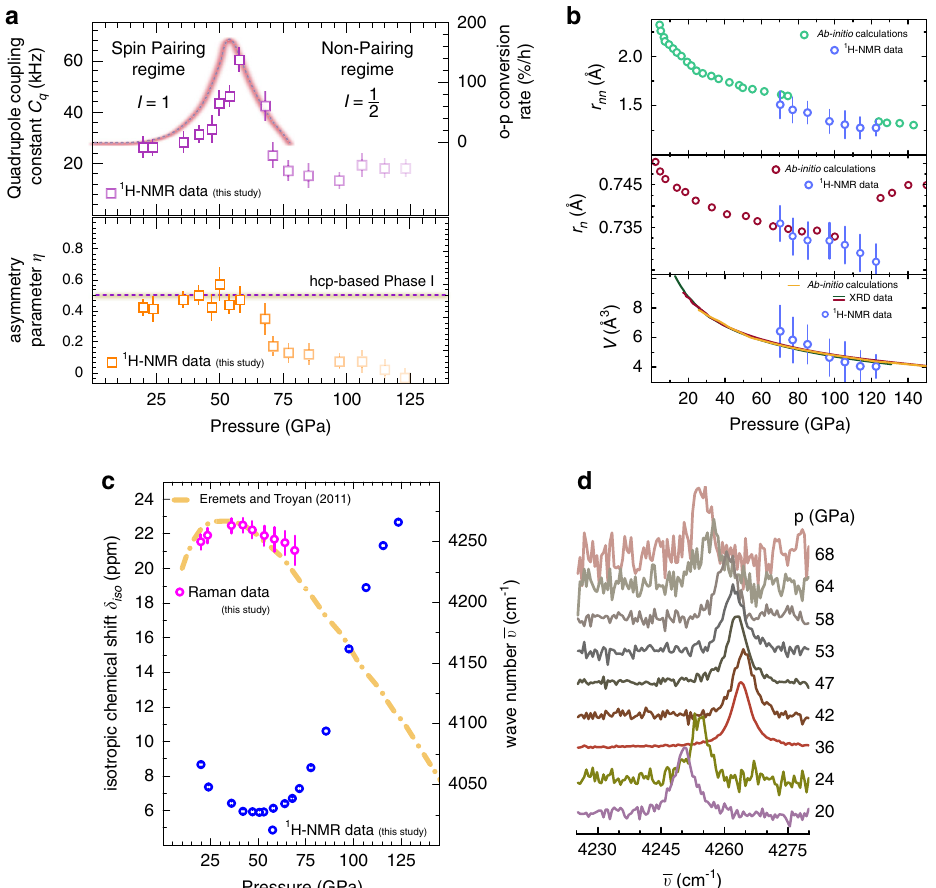
Fig. 3 Extracted 1 H-NMR data of molecular H 2 at pressures up to 123 GPa at room temperature. a Top panel: quadrupole coupling constant C q determined from NMR data (squares). The rose line denotes theoretical ortho – para conversion rates from electric quadrupole interaction 27 . Bottom panel: asymmetry parameter η in the spin-pairing regime ( P < 60 GPa). The dashed line represents the inferred η based on the hcp structure of Phase I from diffraction experiments. The shading of the squares at P > 60 GPa highlights the crossover to the non-pairing I = 1/2 regime. b Top panel: next-nearest neighbour distances r nn . Green circles are based on DFT computations 15 . Blue circles are extracted values of r n and r nn from the NMR spectra in the non- pairing I = 1/2 regime. Middle panel: nearest neighbour distances r n (blue circles) and DFT calculations 15 (red circles). The discontinuity at P > 125 GPa in the DFT calculations indicates a transition from the hcp based to a monoclinic structure. Bottom panel: comparison between the equations of state derived from ab initio computations 23 (yellow line) and diffraction data 14,21 along with the unit cell volumes (blue dots) derived from r nn and r n extracted from the NMR experiments. c Extracted isotropic chemical shift values δ iso after homonuclear Lee – Goldberg decoupling. Error bars are within the symbol size. The orange dotted line shows the room temperature Raman shift of the H 2 vibron 25 . d Selected Raman spectra of the H 2 vibron at increasing pressure. Spectra up to 64 GPa are taken from ref. 25 . Error bars in a and b were taken from spectral simulation and comparison with experimental data. Error bars in c are taken from Voigtian spectral line shape fi tting to the experimental data. Error bars of the NMR data after Lee – Goldburg decoupling (blue points in c ) were within the symbol